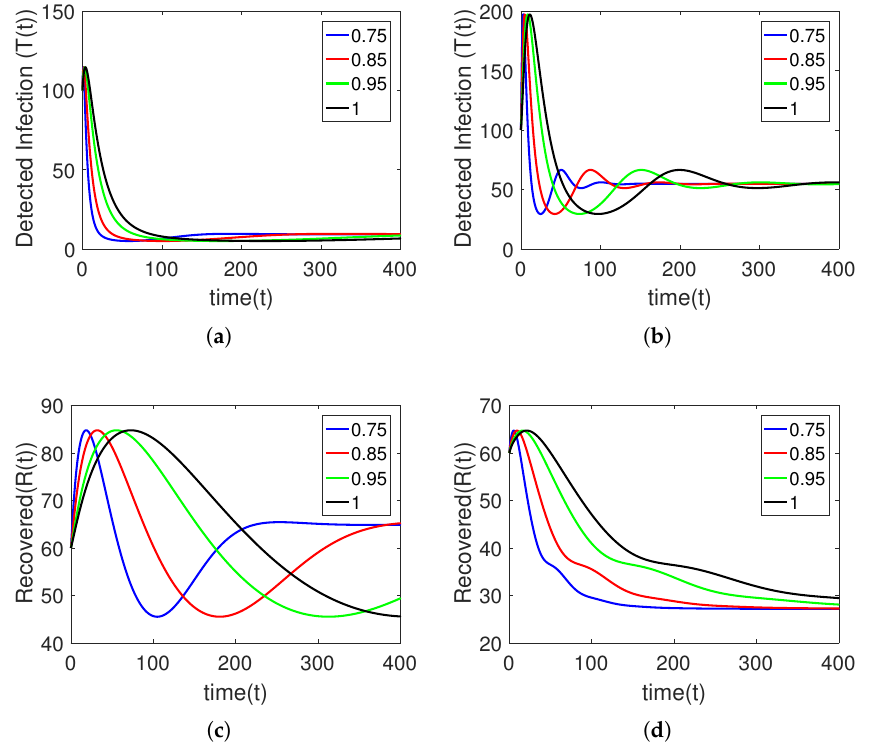
Figure 18. Graphical view ( a – d ) of last two classes on different arbitrary orders γ = 0.75,0.85,0.95,1 for initial data and time duration for TB model by taking the value of α =